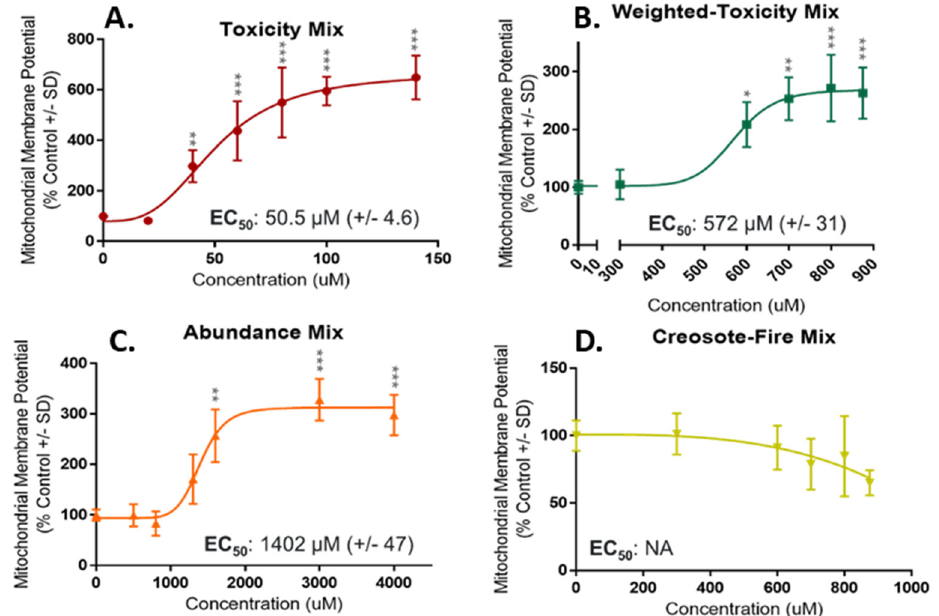
Figure 4. Concentration-Response Curves for Mitochondrial Membrane Potential in NHBE. Curves are in order of decreasing potency based on predicted EC 50 values. ( A ) Toxicity Mix was the most potent mixture with an EC 50 of 50.5 µ M. ( B ) Weighted-Toxicity Mix was the second most potent mixture with an EC 50 of 572 μ M. ( C ) Abundance Mix was the least potent mixture with EC 50 of 1402 μ M. ( D ) Creosote ‐ Fire Mix did not elicit significant bioactivity compared to control, no EC 50 was calculated. Concentrations significantly different from control are denoted with an asterisk (*). p < 0.05 *; p < 0.01 **; p < 0.001 ***.